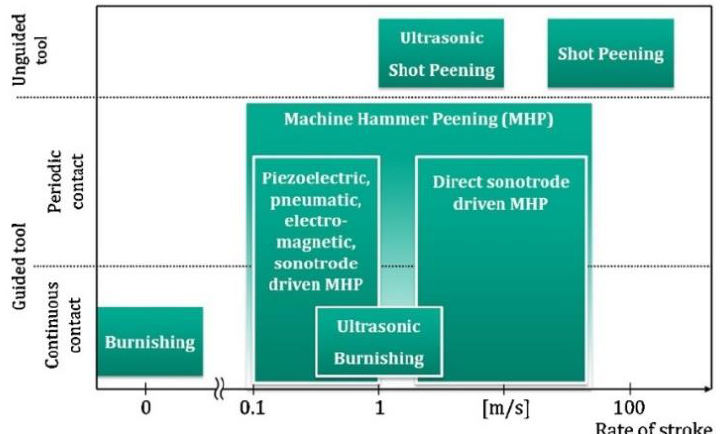
Figure 2. Overview of surface modification processes with guided and unguided tools (reproduced with permission from Ref. [30], Copyright 2016, Elsevier).